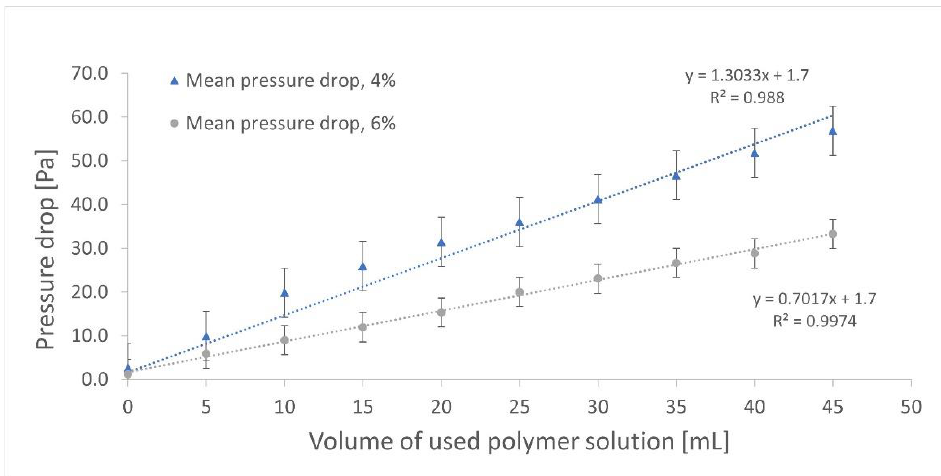
Figure 7. Pressure drop as a function of solution volume.